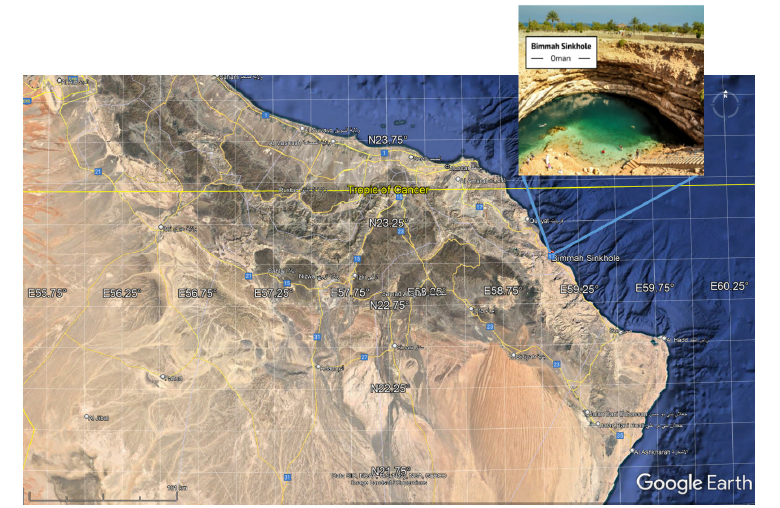
Figure 1. Google map depicting the location of the survey area. North is at the top of the image. The study area is located near the shoreline. Interesting geological features and structures in bathymetry are visible.